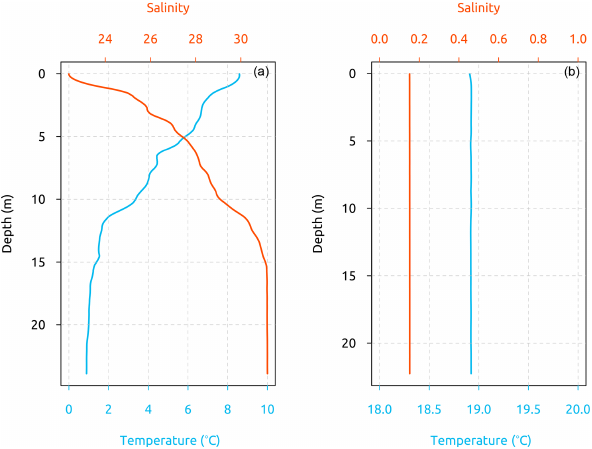
Figure C1. Two examples of vertical profiles of temperature ( ◦ C) and salinity. (a) STN125 on 28 July 2019. (b) STNR09 on 29 July 2019. Note the difference in scales for temperature and salinity between the